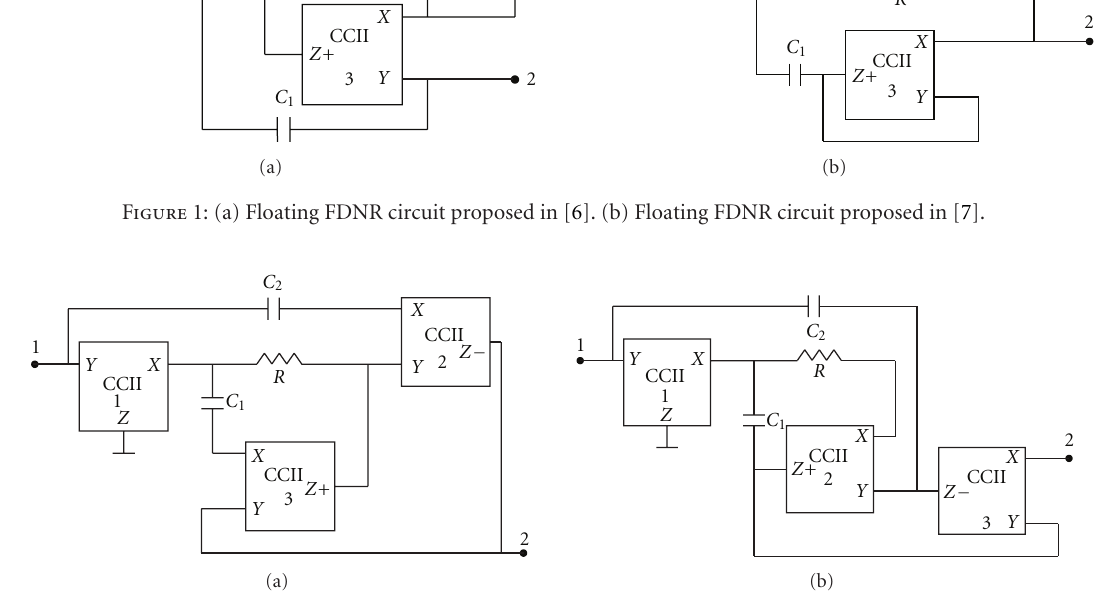
Figure 2: (a) Floating FDNR circuit proposed in [8]. (b) Another floating FDNR circuit proposed in [8].